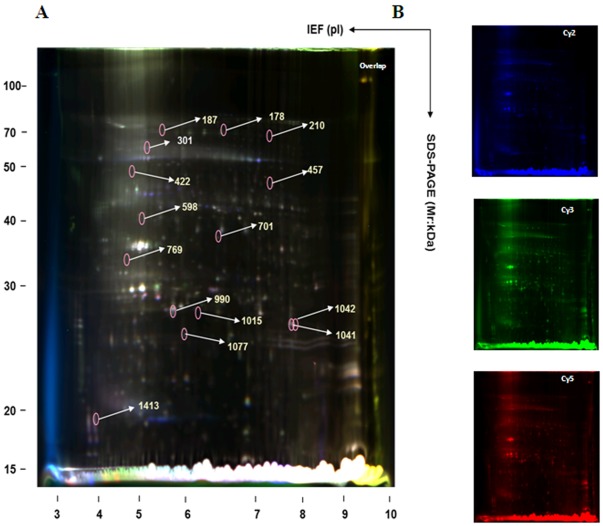
2D-DIGE image analysis of total proteins from the tobacco leaves of Groups B–E.(A) Composite image of Cy2, Cy3 and Cy5 images. (B), (C), and (D) represent the Cy2, Cy3 and Cy5 fluorescent dye images, respectively.